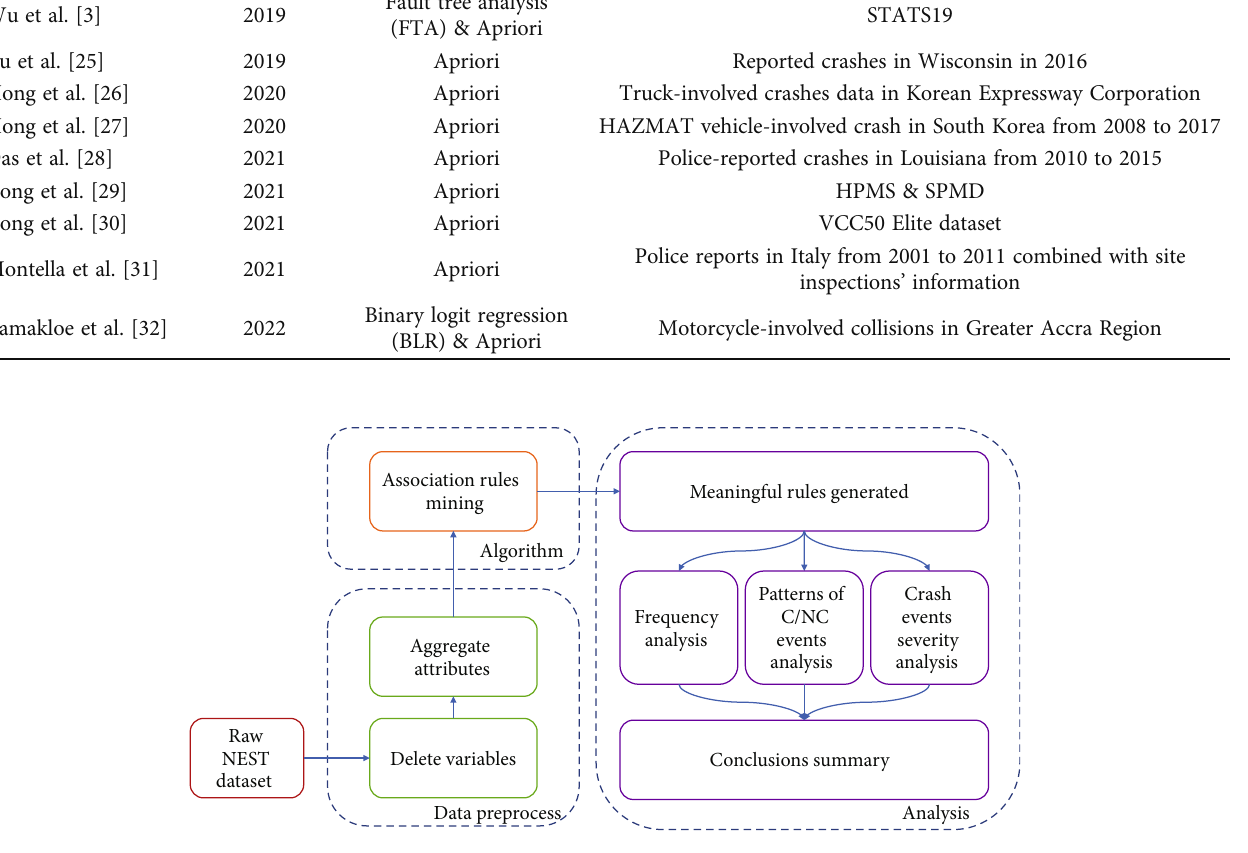
Figure 1: Flowchart of the proposed